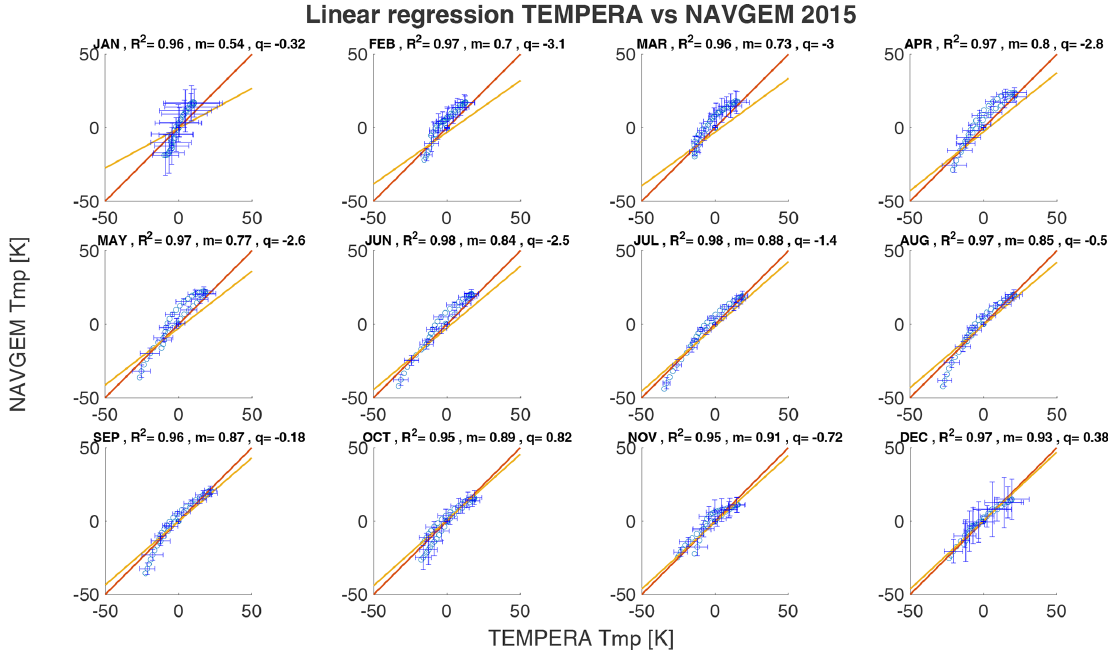
Figure A4. Linear regression of TEMPERA against NAVGEM temperatures for the year 2015.